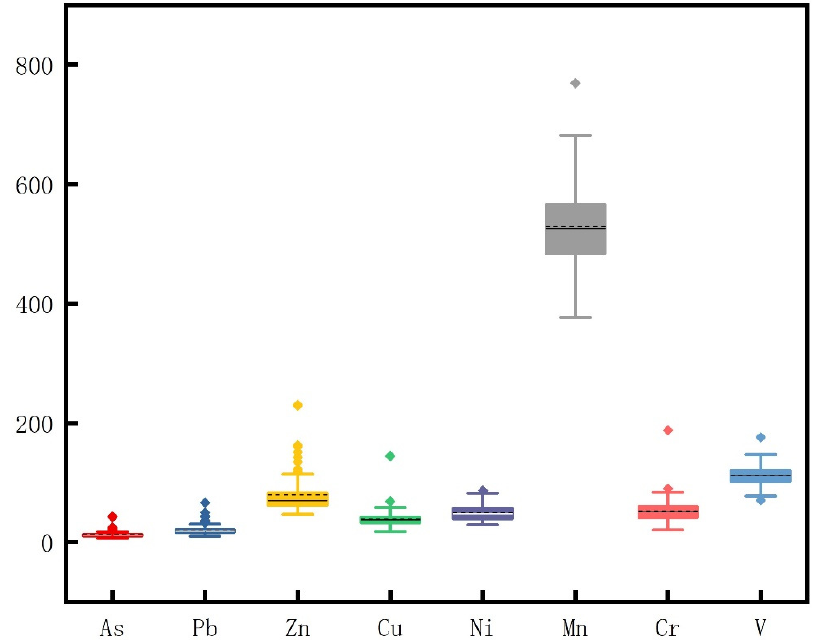
Figure 2. Box Diagram of Eight Heavy Metals Concentrations.